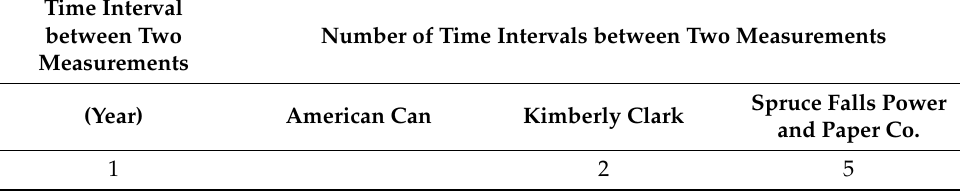
Table A1. Number of measurements for different time intervals between two measurements for the data sets used in this